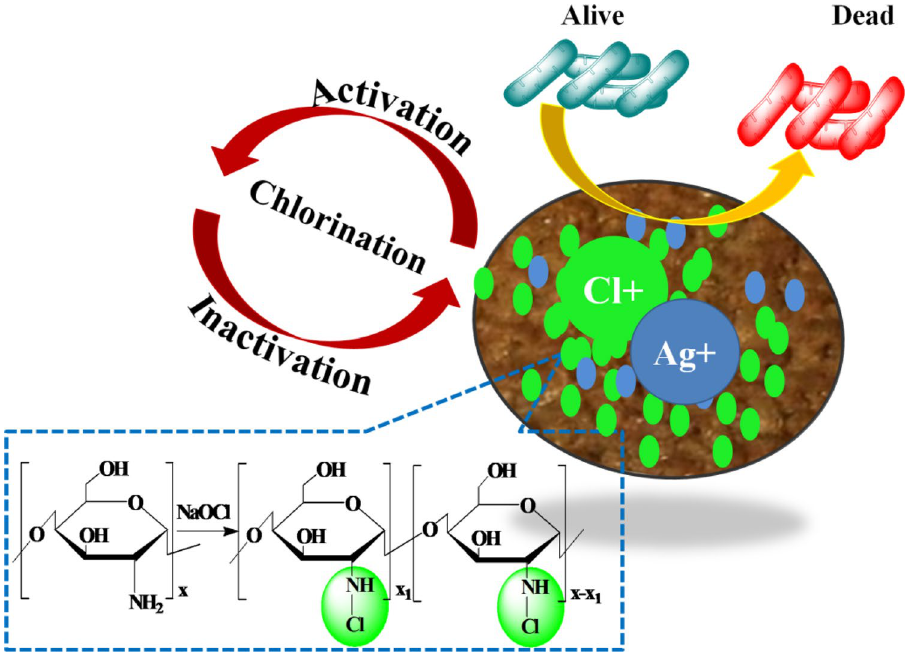
Figure 1. Graphical representation of modified nonwoven cotton fabric and antibacterial